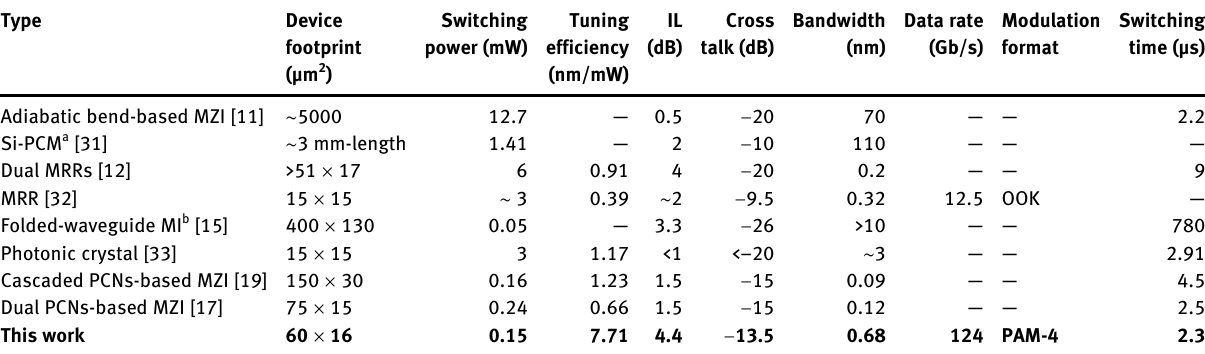
a PCM, Phase change material; b MI, Michelson interferometer.